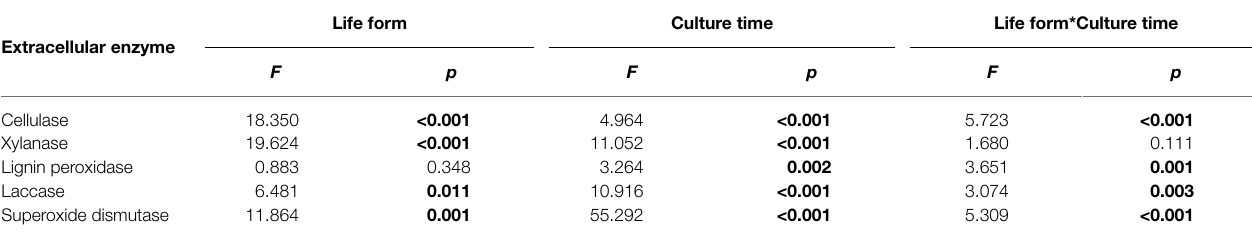
TABLE 2 | Effect of host plant life form (epiphytic vs. terrestrial) and culture time on extracellular enzyme activity. Extracellular enzyme